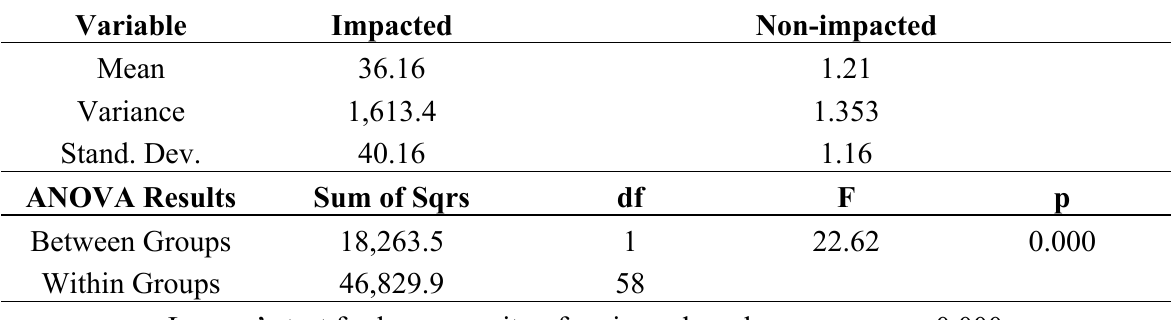
Table 4. ANOVA Results for Anomaly Verification.